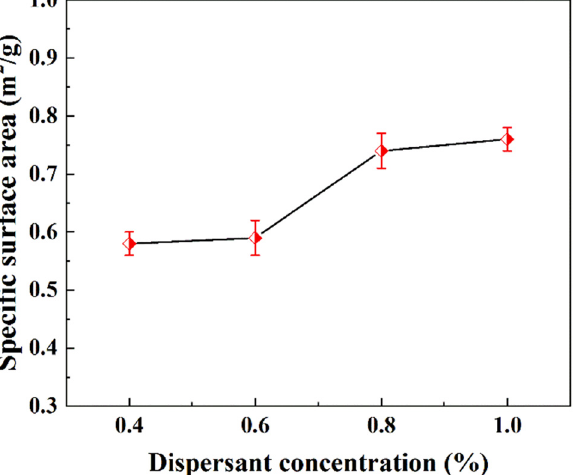
Figure 6: Speci fi c surface area of the silver powder prepared with di ff erent dispersant addition.